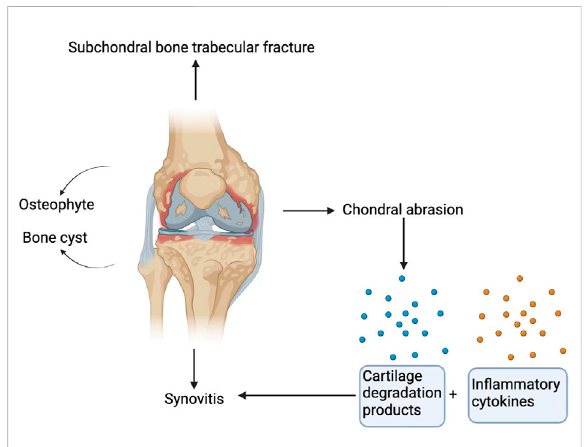
FIGURE 1 Pathologicalmanifestationsofosteoarthritisofthekneejoint. Damage to hyaline articular cartilage is the main cause of osteoarthritis. In addition to cartilage lesions, KOA is accompanied by subchondral trabecular fracture, and bone cysts and osteophytes are also characteristics of KOA. Cartilage degradation products are produced after cartilage injury. These cartilage degradation products and other in fl ammatory factors act on the synoviumtoreleaseprein fl